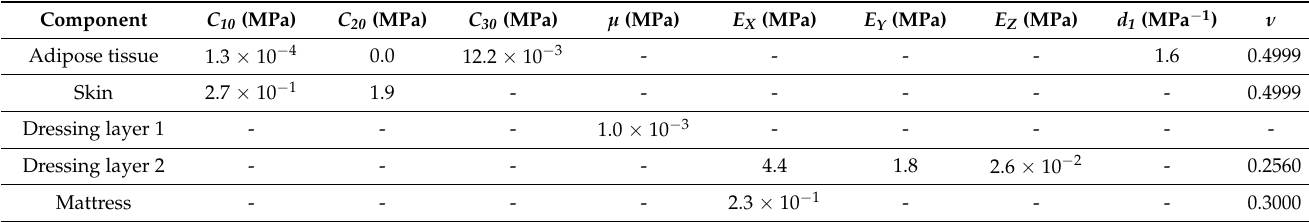
Table 1. Material parameters of the model’s